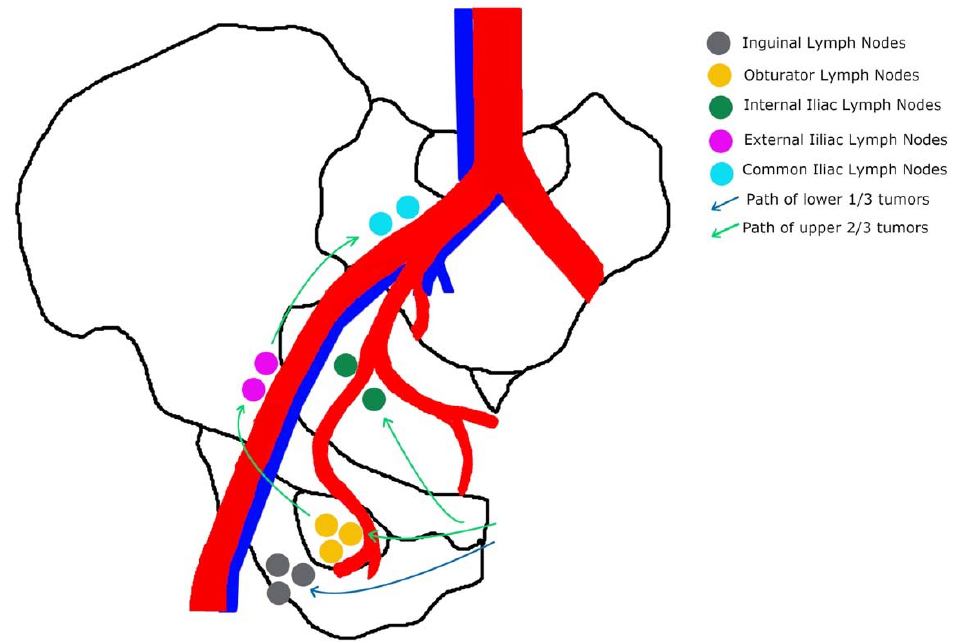
Figure 1. Specific pathway of the lymphatic drainage of vaginal tumors: the upper two-thirds of the vagina drain primarily to pelvic nodes; and the lower one-third drains into the inguinal nodes.